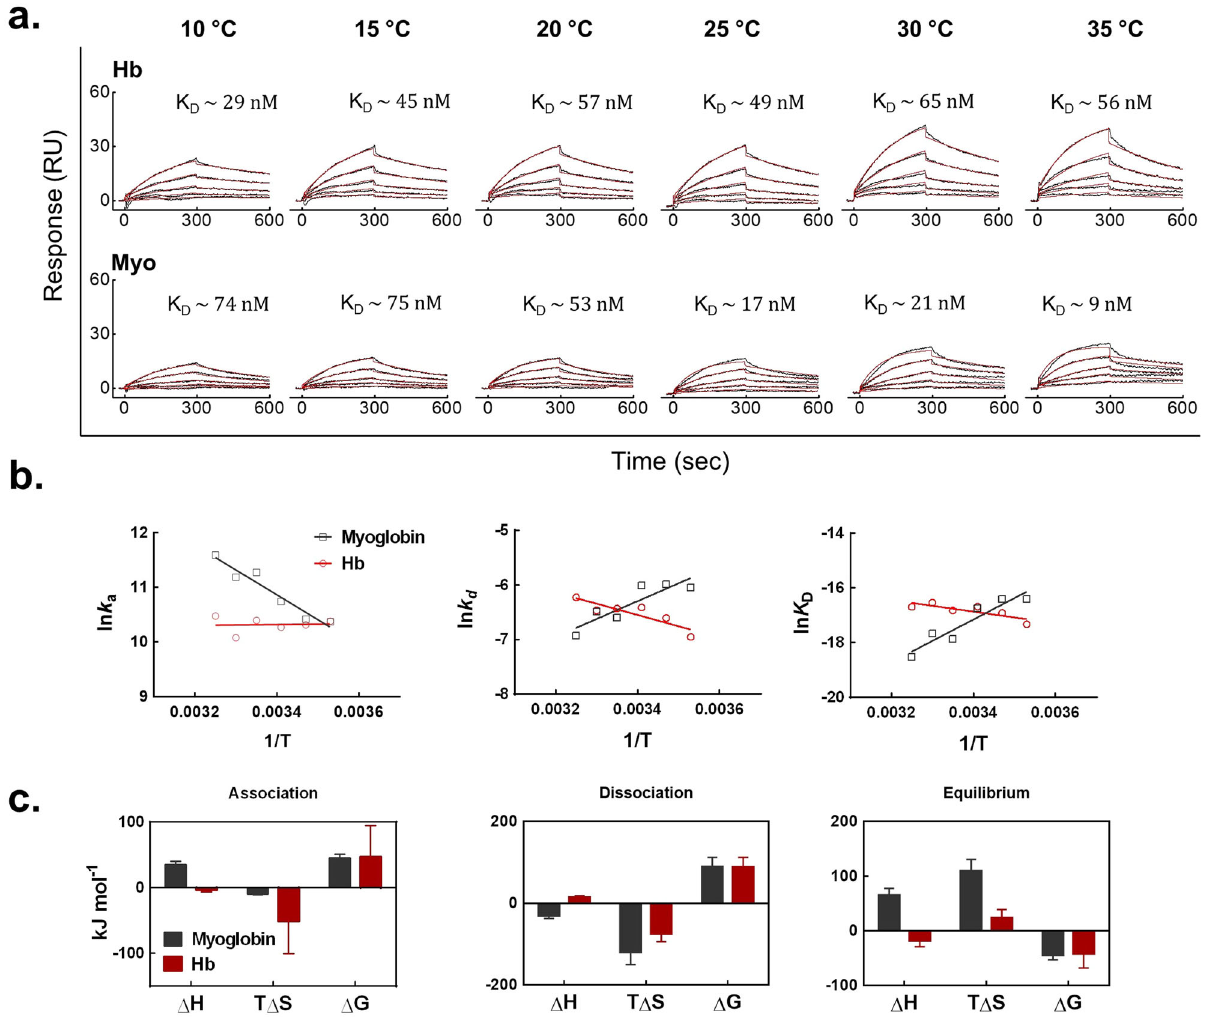
Fig. 6 Quantitative analyses of interaction of Ab21 with Hb and myoglobin. a Real-time interaction pro fi les of heme-exposed Abs21 to immobilized on sensor surface metHb and myoglobin. The black line represents the binding pro fi les obtained after injection of serial dilutions of Ab21 (125 – 7.81 nM). The red lines depict the computed fi ts of data obtained by global kinetic analyses using BIAevaluation software. The kinetic measurements were performed as a function of temperature. Representative sensorgrams from two independent experiments are shown. The average values of equilibrium dissociation constant obtained by three independent fi ttings of the experimental data are shown as inserts. A table with all kinetic values, applied fi tting models and statistics is presented as Supplementary Data 1. b Arrhenius and Van ’ t Hoff plots depicting the temperature dependency of kinetic rate constant and equilibrium dissociation constant of binding of Ab21 to metHb (red line and symbols) and myoglobin (black liens and symbols). The plots were built by linear regression analyses using Graph Pad Prism software v. 6.01. c Changes in activation and equilibrium thermodynamic parameters of interaction of Ab21 to metHb (red bars) and myoglobin (gray bars). The values of the thermodynamic parameters were calculated by Eyring ’ s analyses using slopes of Arrhenius plots depicted in b . Each bar shows change of binding energy ±SE, re fl ecting the standard errors from the linear regression fi ts on b